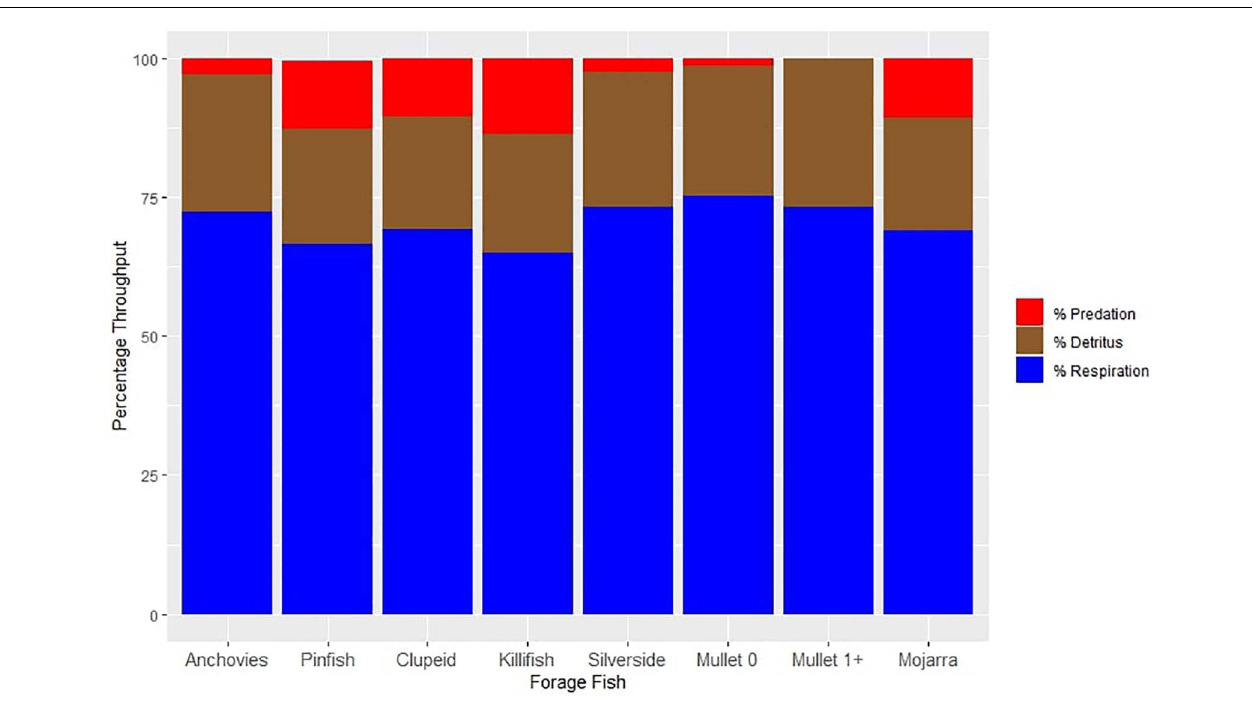
FIGURE 4 | Percent throughput of forage fish taxa. This describes the different fates of biomass for each functional group. Biomass is either lost to predation, decomposes to detritus, or is metabolized through respiration. Values are presented as percentages of total